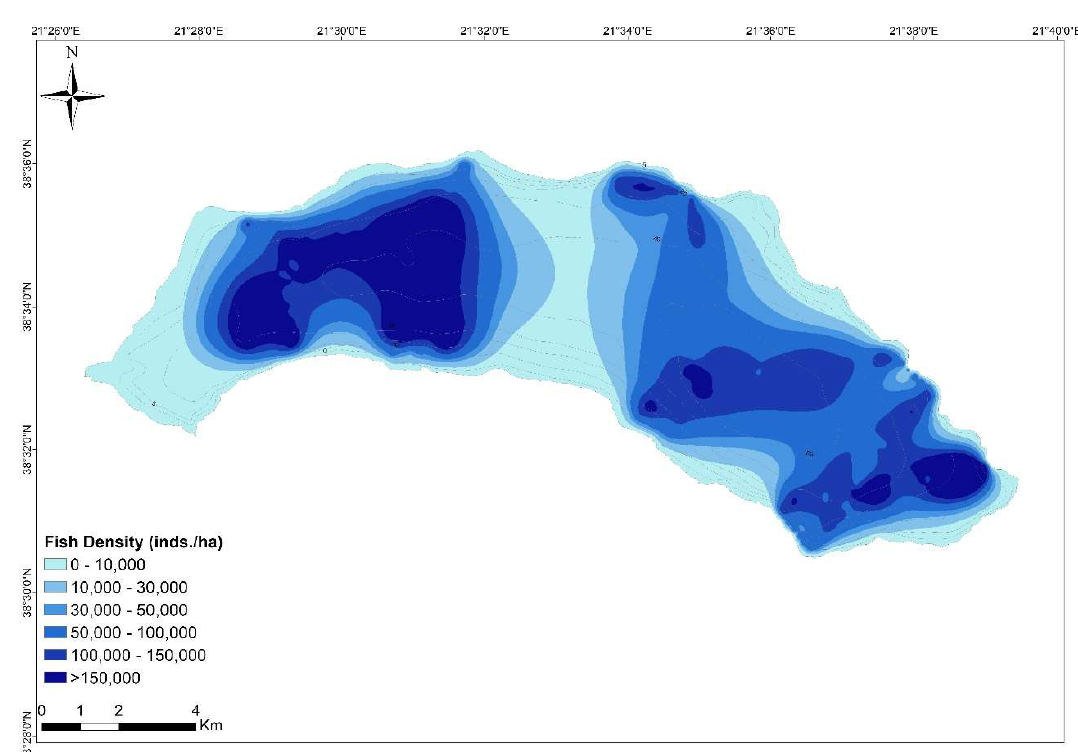
Figure 9. Fish density (inds./ha) distribution during the day survey in lake Trichonis.